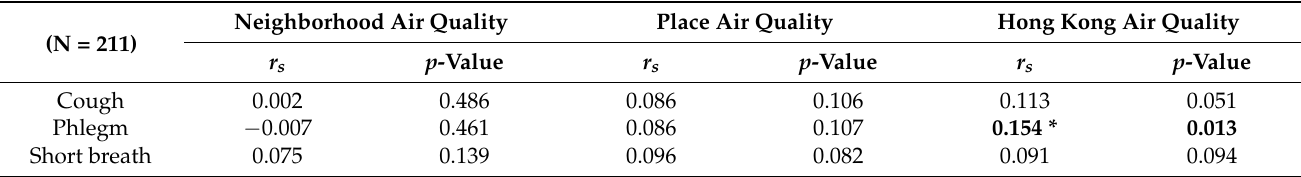
Table 4. The Spearman rank correlation coefficients of the total